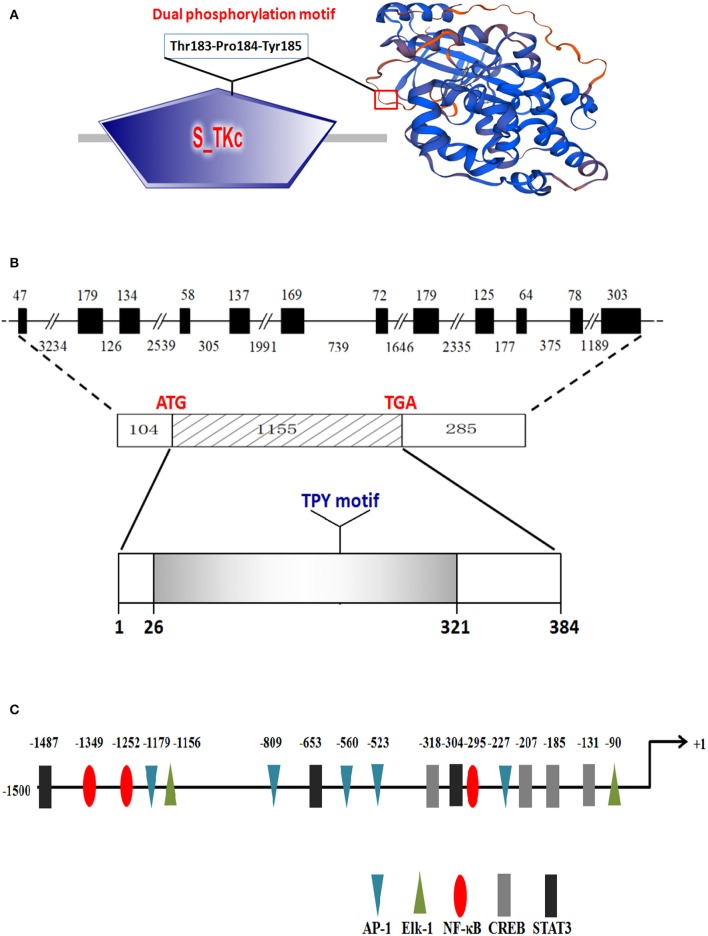
Protein structure and genomic organization of CiJNK. (A) Domain organization and three-dimensional structure of CiJNK as predicted by the SMART tool and Swiss-Model program. (B) Exons and introns are indicated by black boxes and black lines with the corresponding sizes (bp), respectively. (C) Identification of the putative transcription factor binding sites in the 5′-flanking regions (1,500 bp) of the CiJNK gene. The positions of transcription factor binding sites are defined relative to the transcription start site (+1). The predicted transcription factor binding sites are shown by different colors of triangles, ellipses, or rectangles.